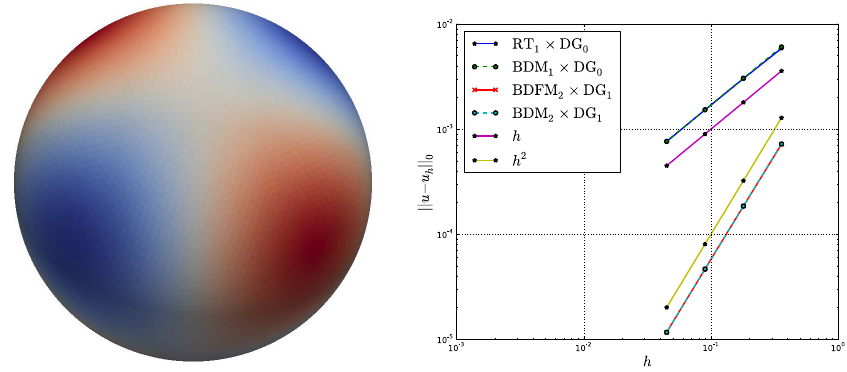
Fig. 7. Left: plot of the solution u to the div-conforming discretisation of the Poisson Eq. (44) with V = RT 1 and Q = DG 0 . Right: k u − u h k 0 versus mesh size h (where u is the exact solution and u h is the numerical solution) for series of discretisations of Eq. (44). Table 1. Triples ( E , V , Q ) of finite element spaces. Only the pairs ( V , Q ) are used in Sects. 5.1.1 and 5.2, while Sect. 5.5